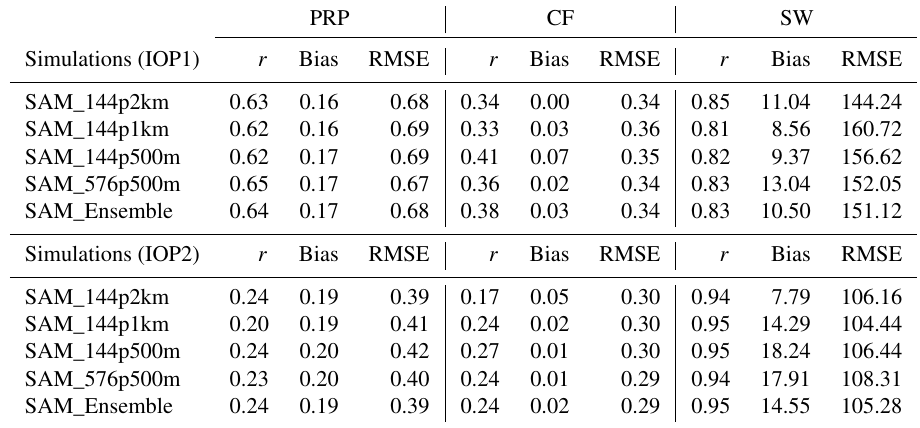
Table 3. Summary of the statistical analysis. The correlation coefficient ( r ), bias and RMSE were calculated between the observed data and each simulation with different horizontal resolutions for the wet (IOP1) and dry (IOP2) periods. PRP